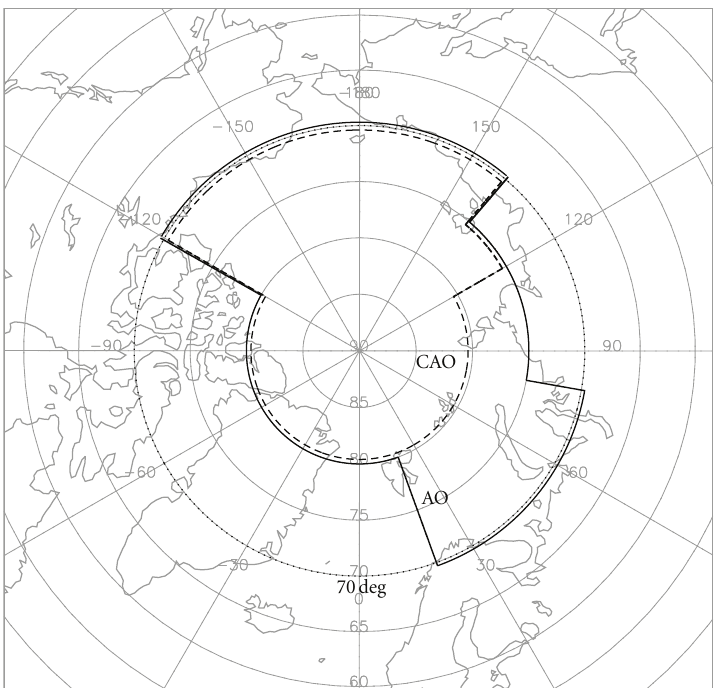
Figure 2: Regional divisions of the Arctic Ocean north of 70 ◦ N from Serreze et al. [40]: Central Arctic Ocean (CAO, dashed), Arctic Ocean (AO, solid), and Polar Cap (70 ◦ N,